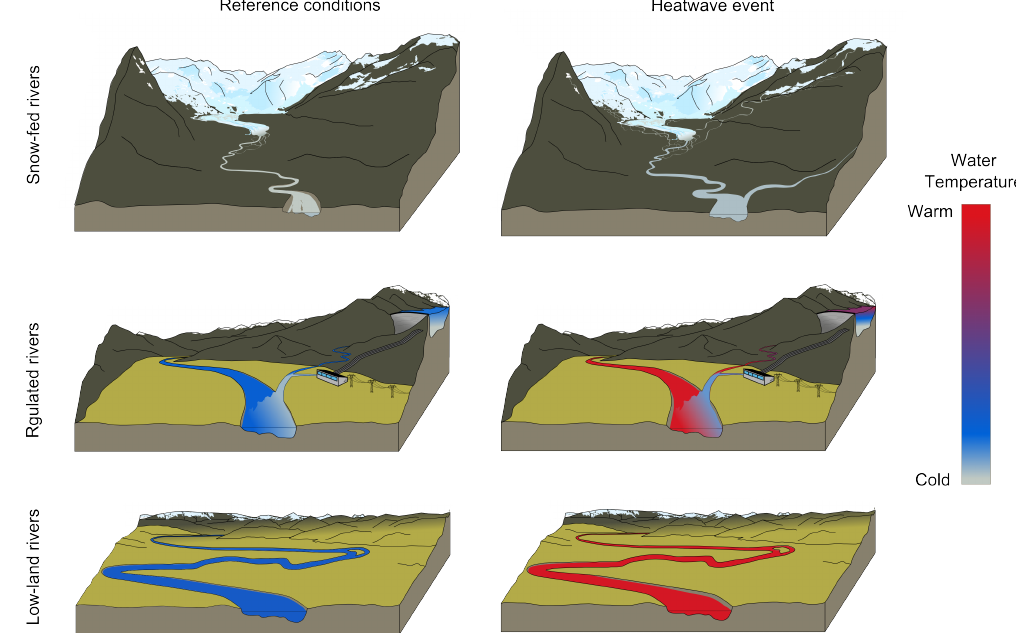
Figure 7. Qualitative description of the different hydrological categories of rivers investigated in this work and of their different response to heatwaves: ‘snow-fed’ rivers comprise natural rivers at high altitude and at short distance downstream of a glacier or snowfield; ‘regulated’ rivers flow along mountain valley floors and are affected by water releases from higher altitudes through anthropogenic regulations; ‘low-land’ rivers are rivers not significantly affected by anthropogenic flow releases, located at low altitudes, and characterized by large catchment areas. Snow-fed and regulated rivers are thermally resilient rivers showing a mild response to heatwaves thanks to cold water releases from high altitudes. Low-land rivers are thermally reactive rivers showing a significant response to heatwave